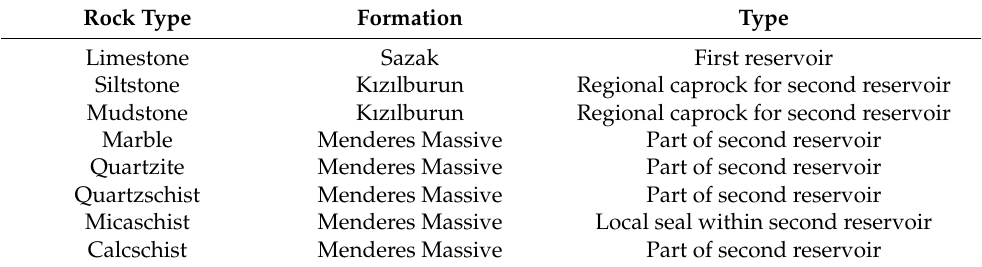
Table 1. Rock types collected from fresh outcrops in the region around the K ı z ı ldere site.